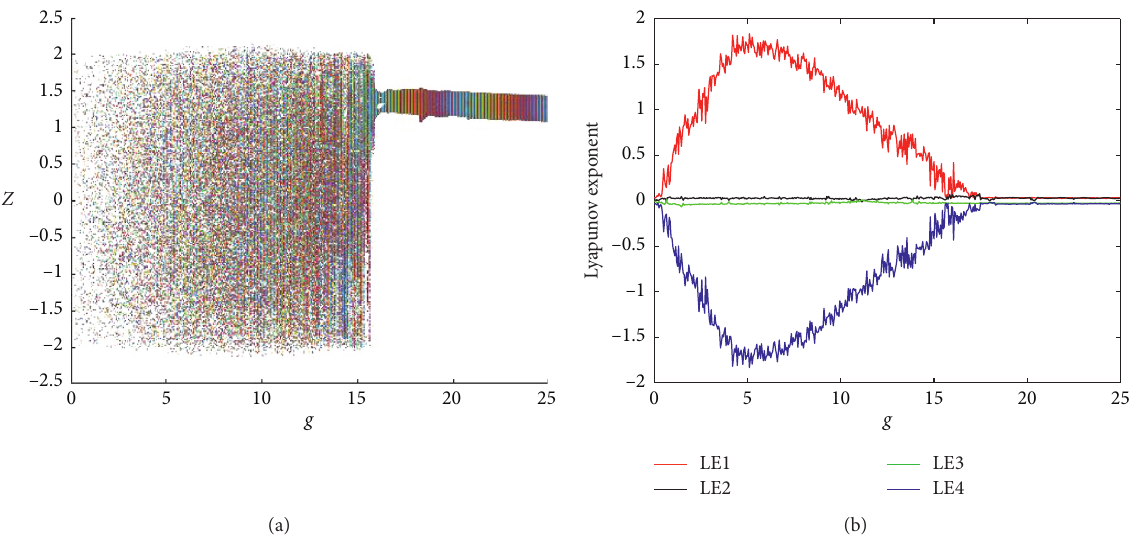
Figure 12: Lyapunov exponent spectrum and bifurcation diagram of Case 2 system versus g . (a) Bifurcation diagram. (b) Lyapunov exponent